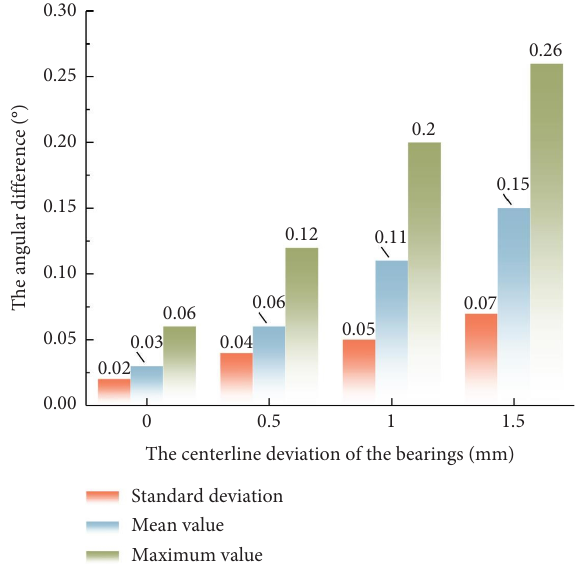
Figure 17: Comparison of errors under the four types of deviation values.